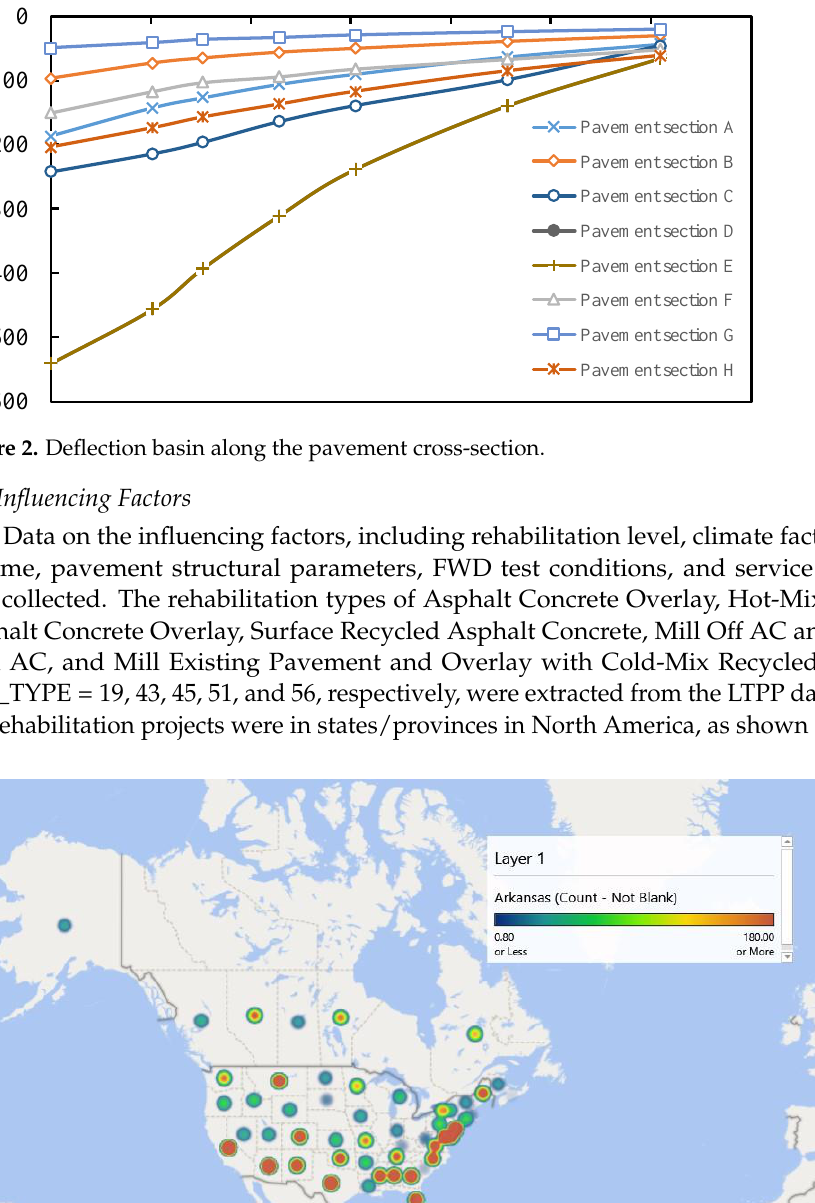
Table 1. Center offsets of seven deflection measurements .